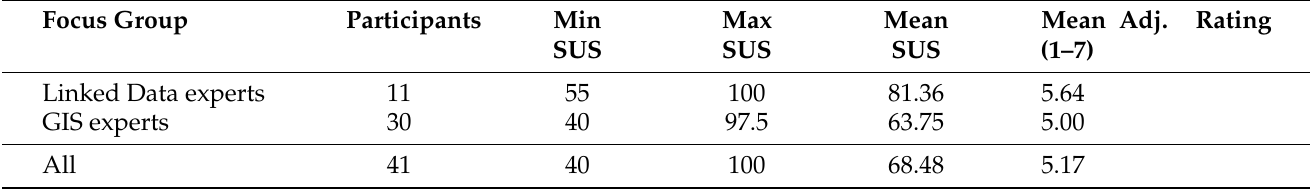
Table 7. Standard Usability Scale (SUS) with adjective rating questionnaire results.